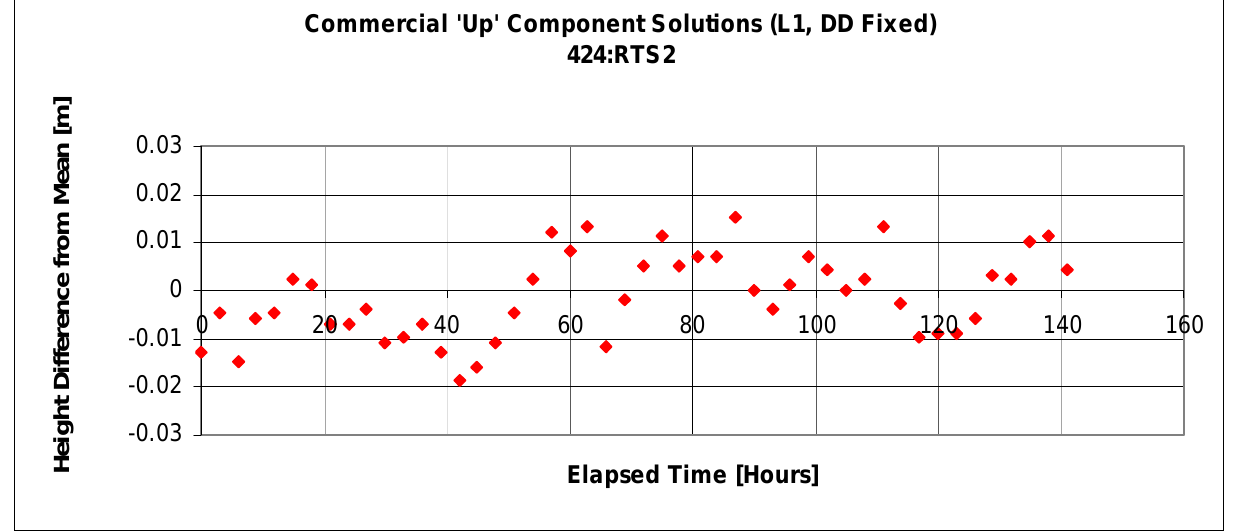
Figure 2 . Commercial, 3 Hour, DD Fixed, ‘Up’ Component